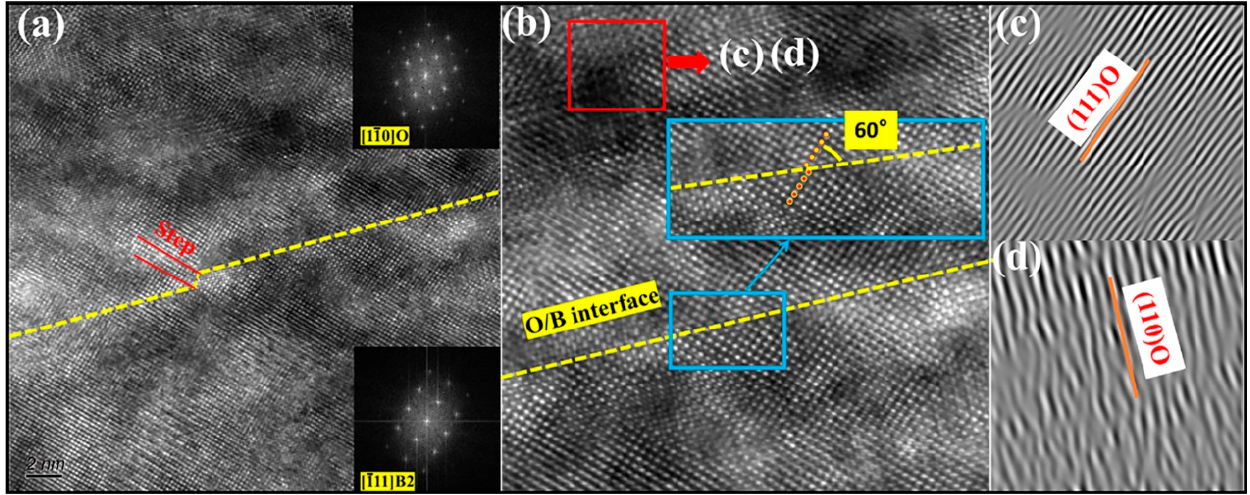
Figure 15. ( a ) High-resolution TEM image of S4 (scanning speed: 900 mm/s). ( b ) Magnified image corresponding to ( a , c , d ) inverse Fourier-filtered HRTEM images corresponding to the red rectangle area in Figure 15b.